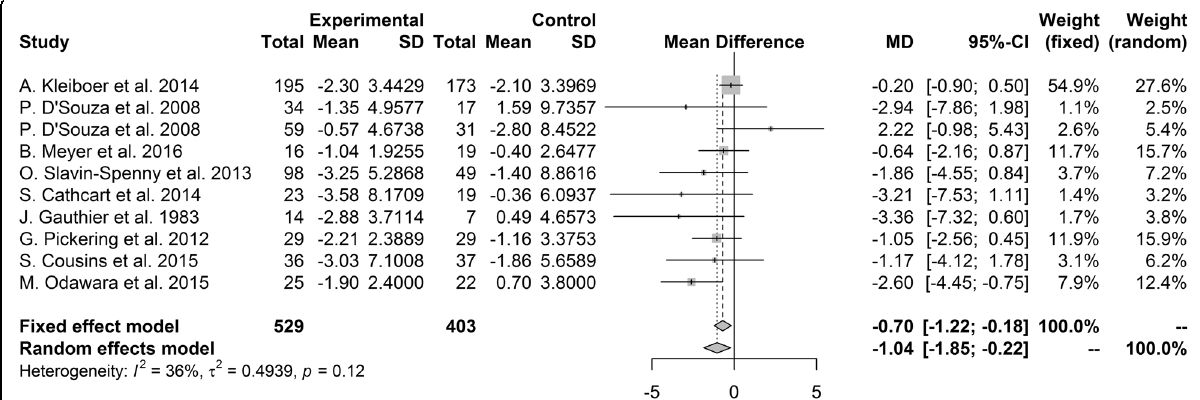
Fig. 2 Forest plot of headache frequency measured by number of headache days